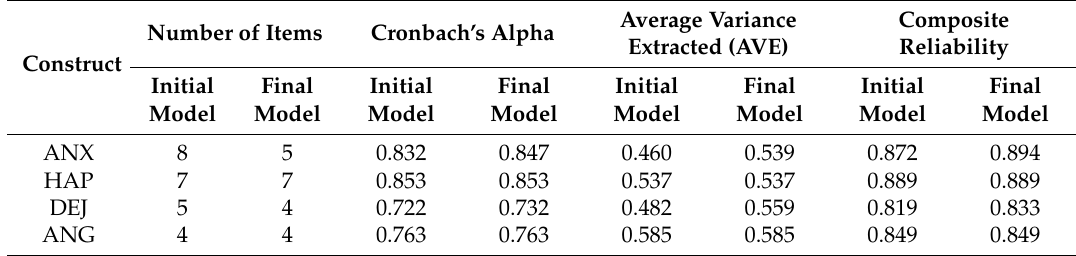
Table 4. Reliability and convergent validity: comparison of the initial and final structural model.